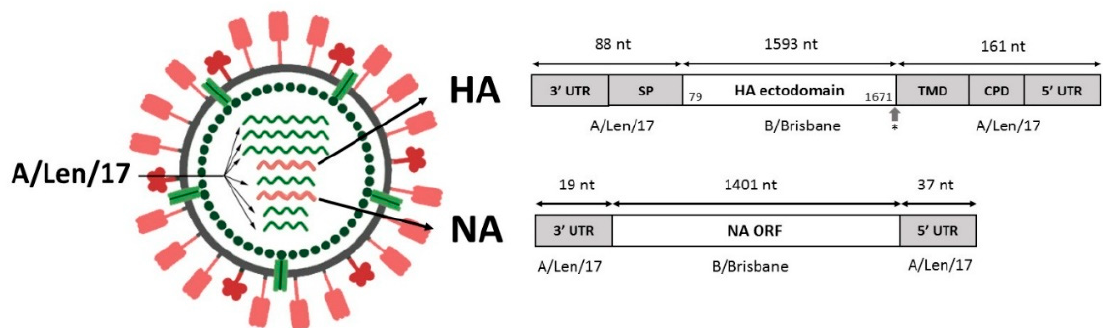
Figure 2. Chimeric A/B genome composition and a scheme of hemagglutinin (HA) and neuraminidase (NA) genetic segments: the chimeric H2B reassortant virus contains six genetic segments from A/Leningrad/134/17/57 (A/Len/17) (H2N2) LAIV master donor virus (MDV) (shown in green). Segments encoding HA and NA are engineered constructs on the base of parts of A/Len/17 and B/Brisbane/60/2008 (B/Brisbane) (shown in red). In the scheme of segment constructions, exact numbers of nucleotides are specified. For the B/Brisbane HA ectodomain, the positions of start and end nucleotides in the B/Brisbane/60/08 HA segment are indicated. At the end of the B/HA ectodomain, His545 was changed to Tyr, corresponding to A/Len/17 appropriate position (shown with grey arrow). SP: HA signal peptide, TMD: transmembrane domain, CPD: cytoplasmic domain, UTR: untranslated region.